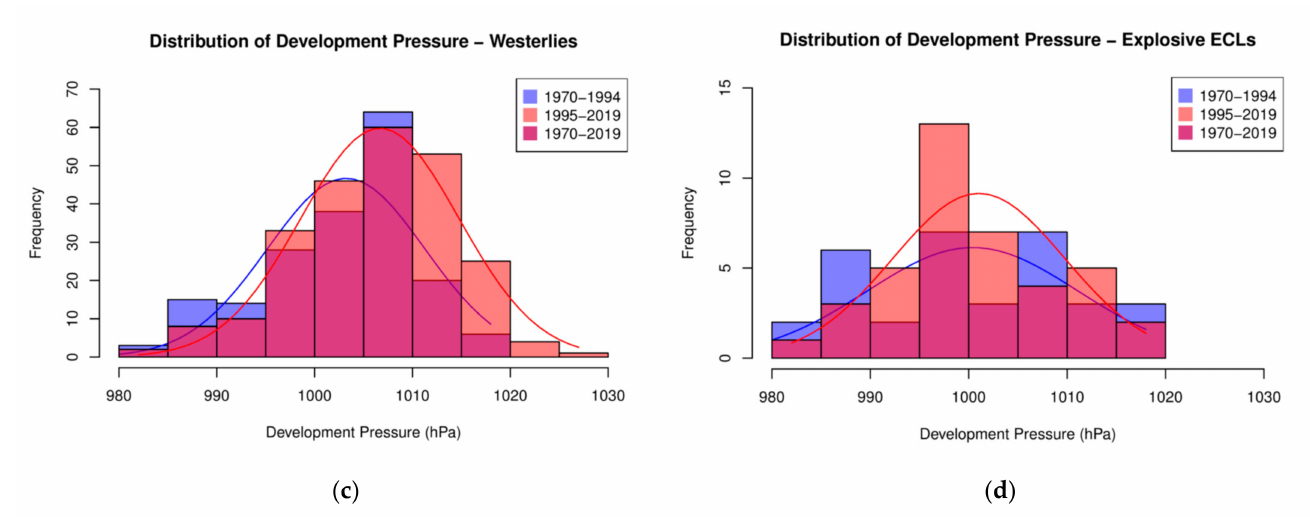
Figure 5. Histogram plots of ECL development mean central pressure distribution for periods April–September 1970– 1994 and 1995–2019 for ( a ) Total, ( b ) Easterlies, ( c ) Westerlies, and ( d ) Explosives. Solid lines are the normal distribution interpolation of the